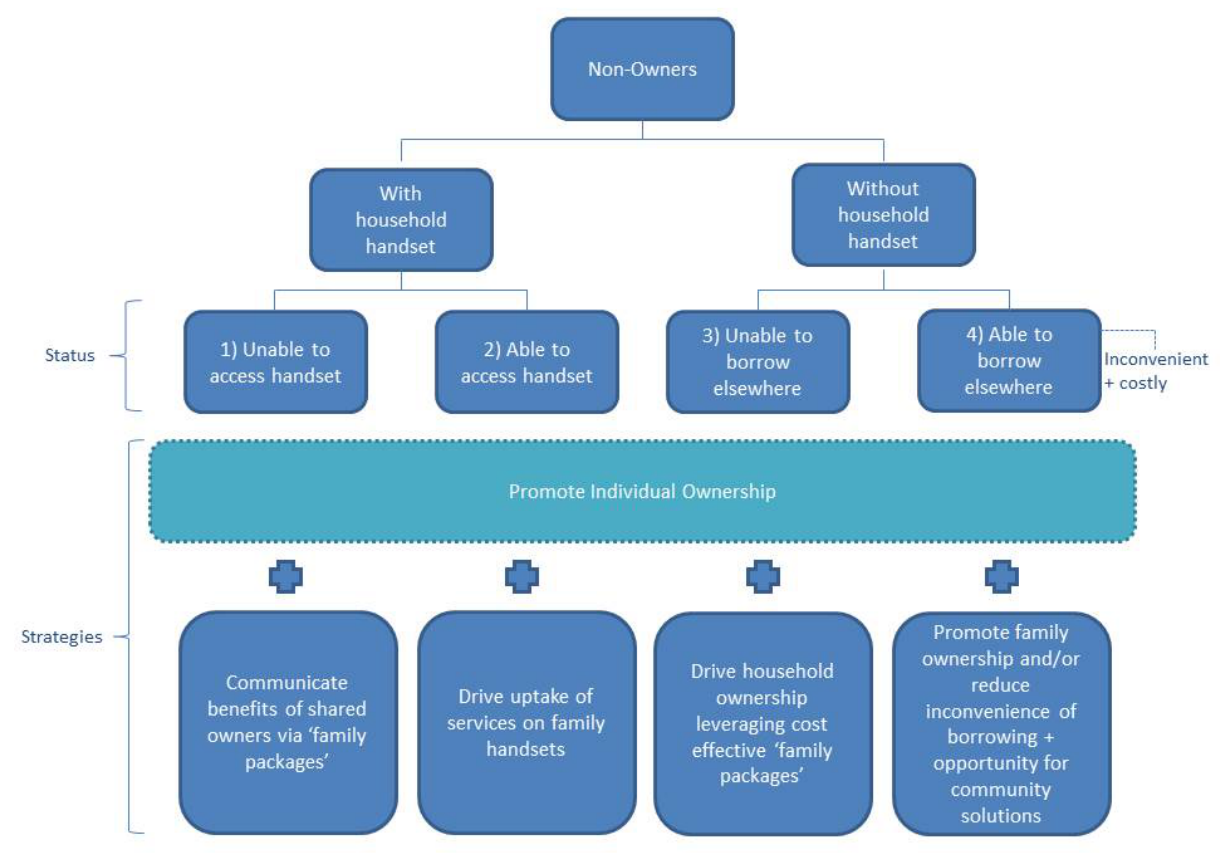
Figure 4. GSMA mWomen strategies to promote individual ownership. Source: